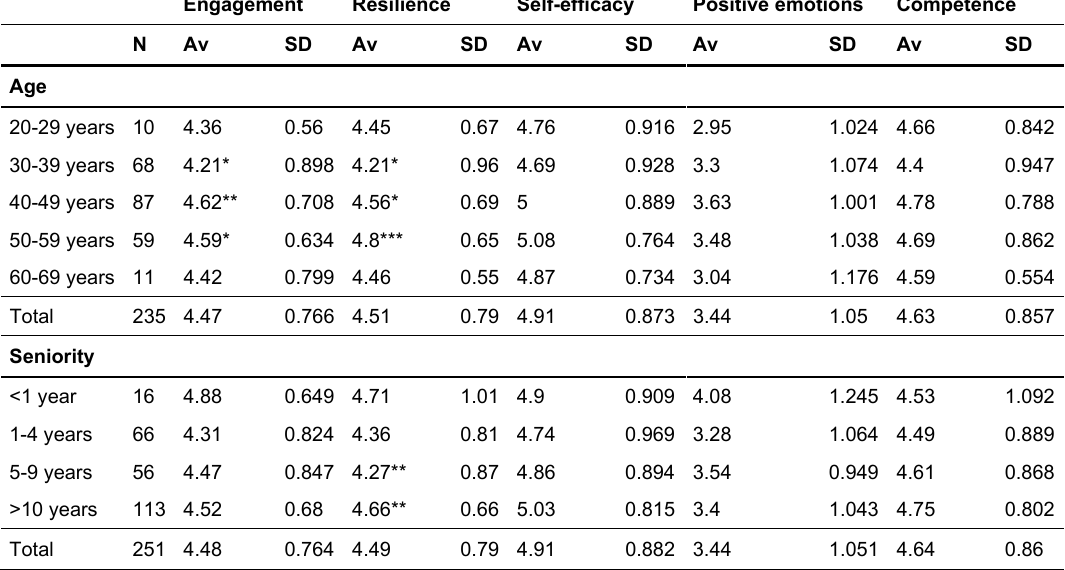
Engagement Resilience Self-efficacy Positive emotions Competence